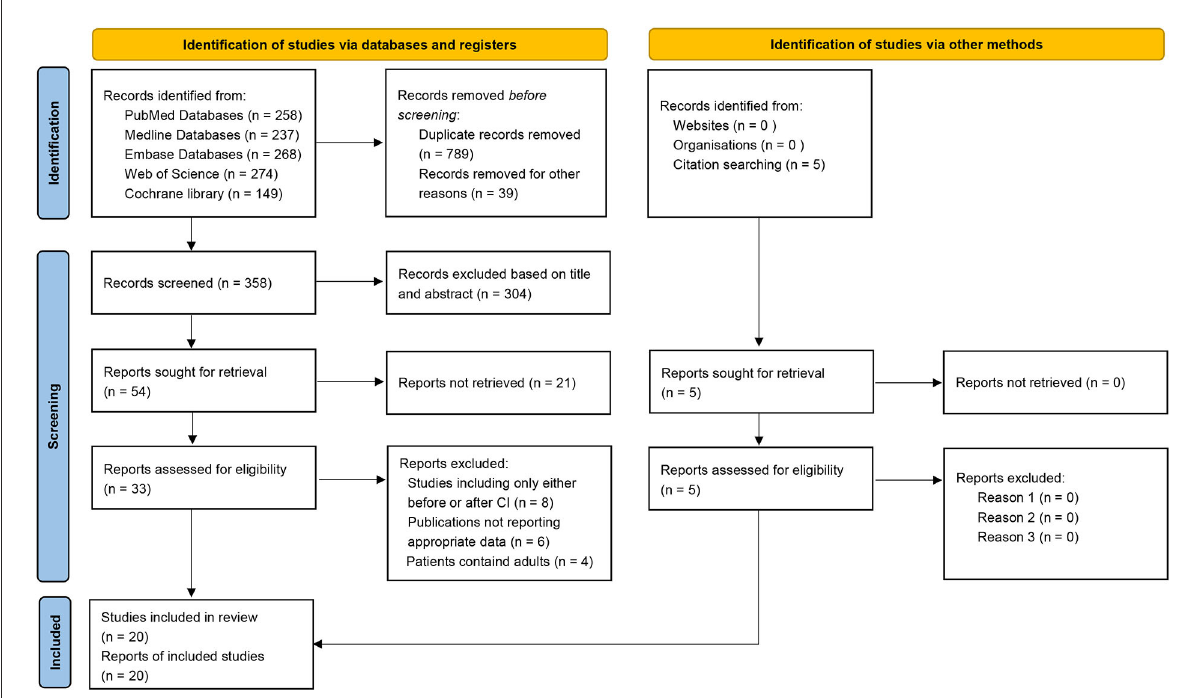
FIGURE1 PRISMA flow diagram of the systematic literature search